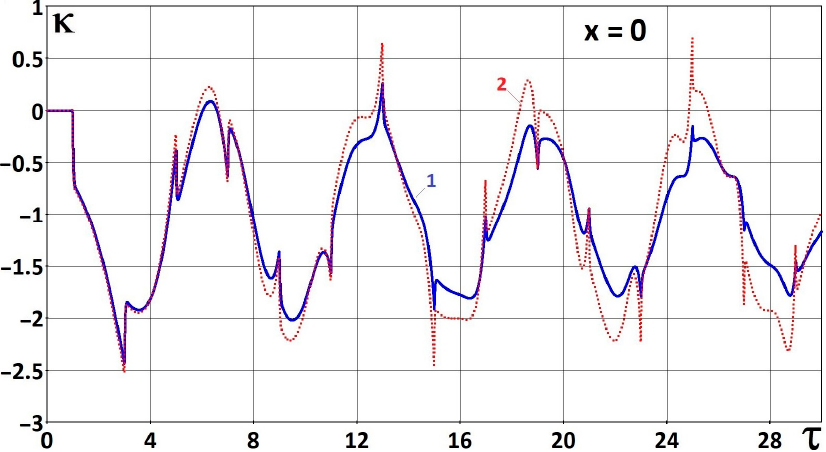
Figure 5. Time history of the relative stress at x = 0 for the case of an exponential increase in FGM properties with increasing x . Viscoelastic FGM—curve 1, elastic FGM—curve 2. Curve 2 is obtained for γ v ≡ γ s ≡ 0 (linear elastic